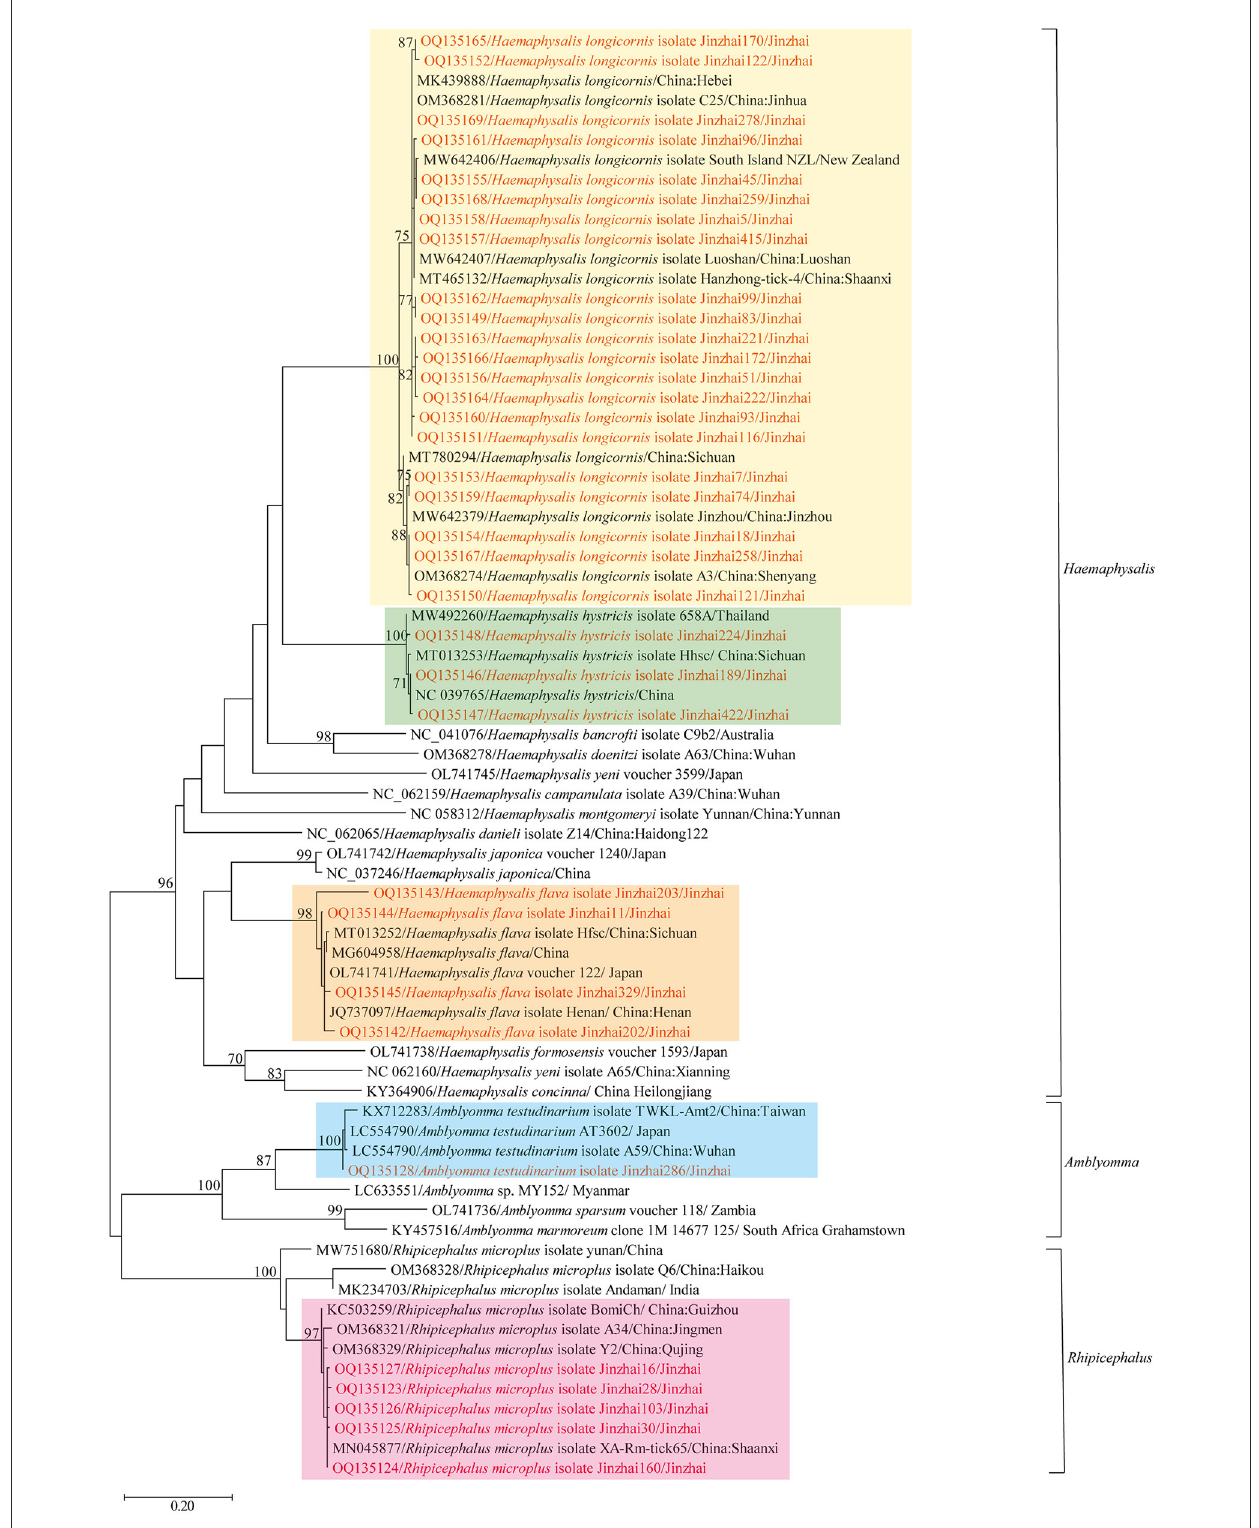
FIGURE2 Phylogenetic tree showing the relationship of Haemaphysalis longicornis , Rhipicephalus microplus , Haemaphysalis hystricis , Haemaphysalis flava , and Amblyomma testudinarium with other tick species. Evolutionary analyses were conducted using PhyML 3.0. The COI gene sequences amplified in this study were aligned with other tick COI sequences available on GenBank. Sequences obtained in this study are marked in